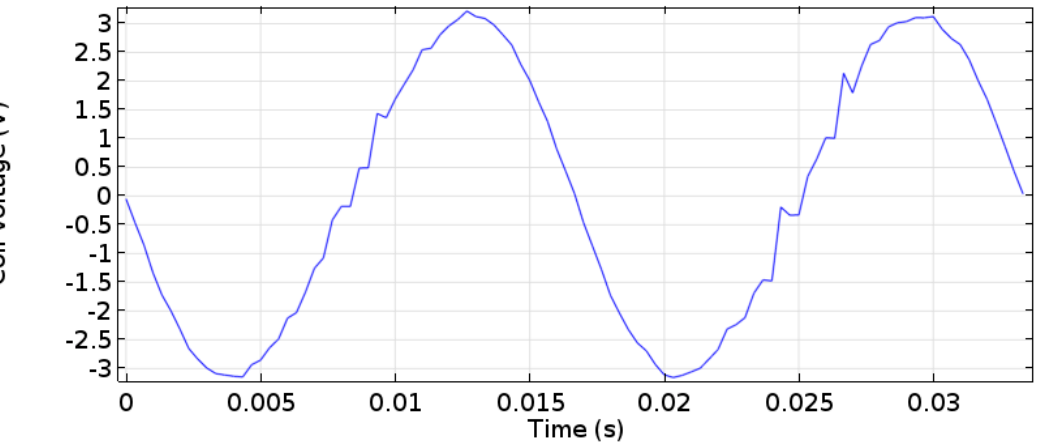
Figure 9. Measured open-circuit voltage waveform of the Windbelt flutter energy harvester device.